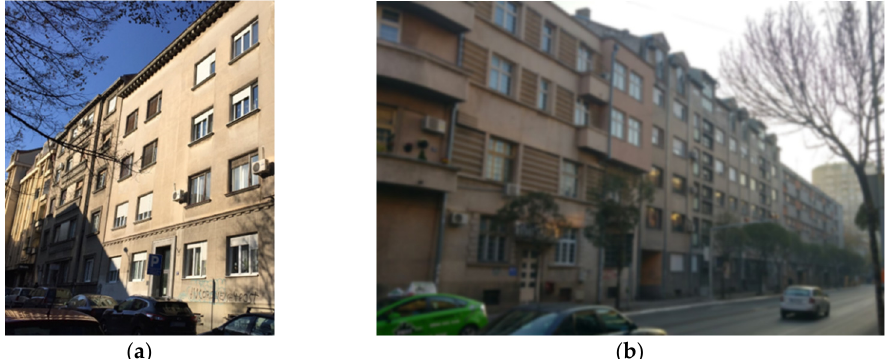
Figure 1. Examples of URM multi-family residential buildings in Serbian cities: ( a ) Belgrade and ( b ) Niš.